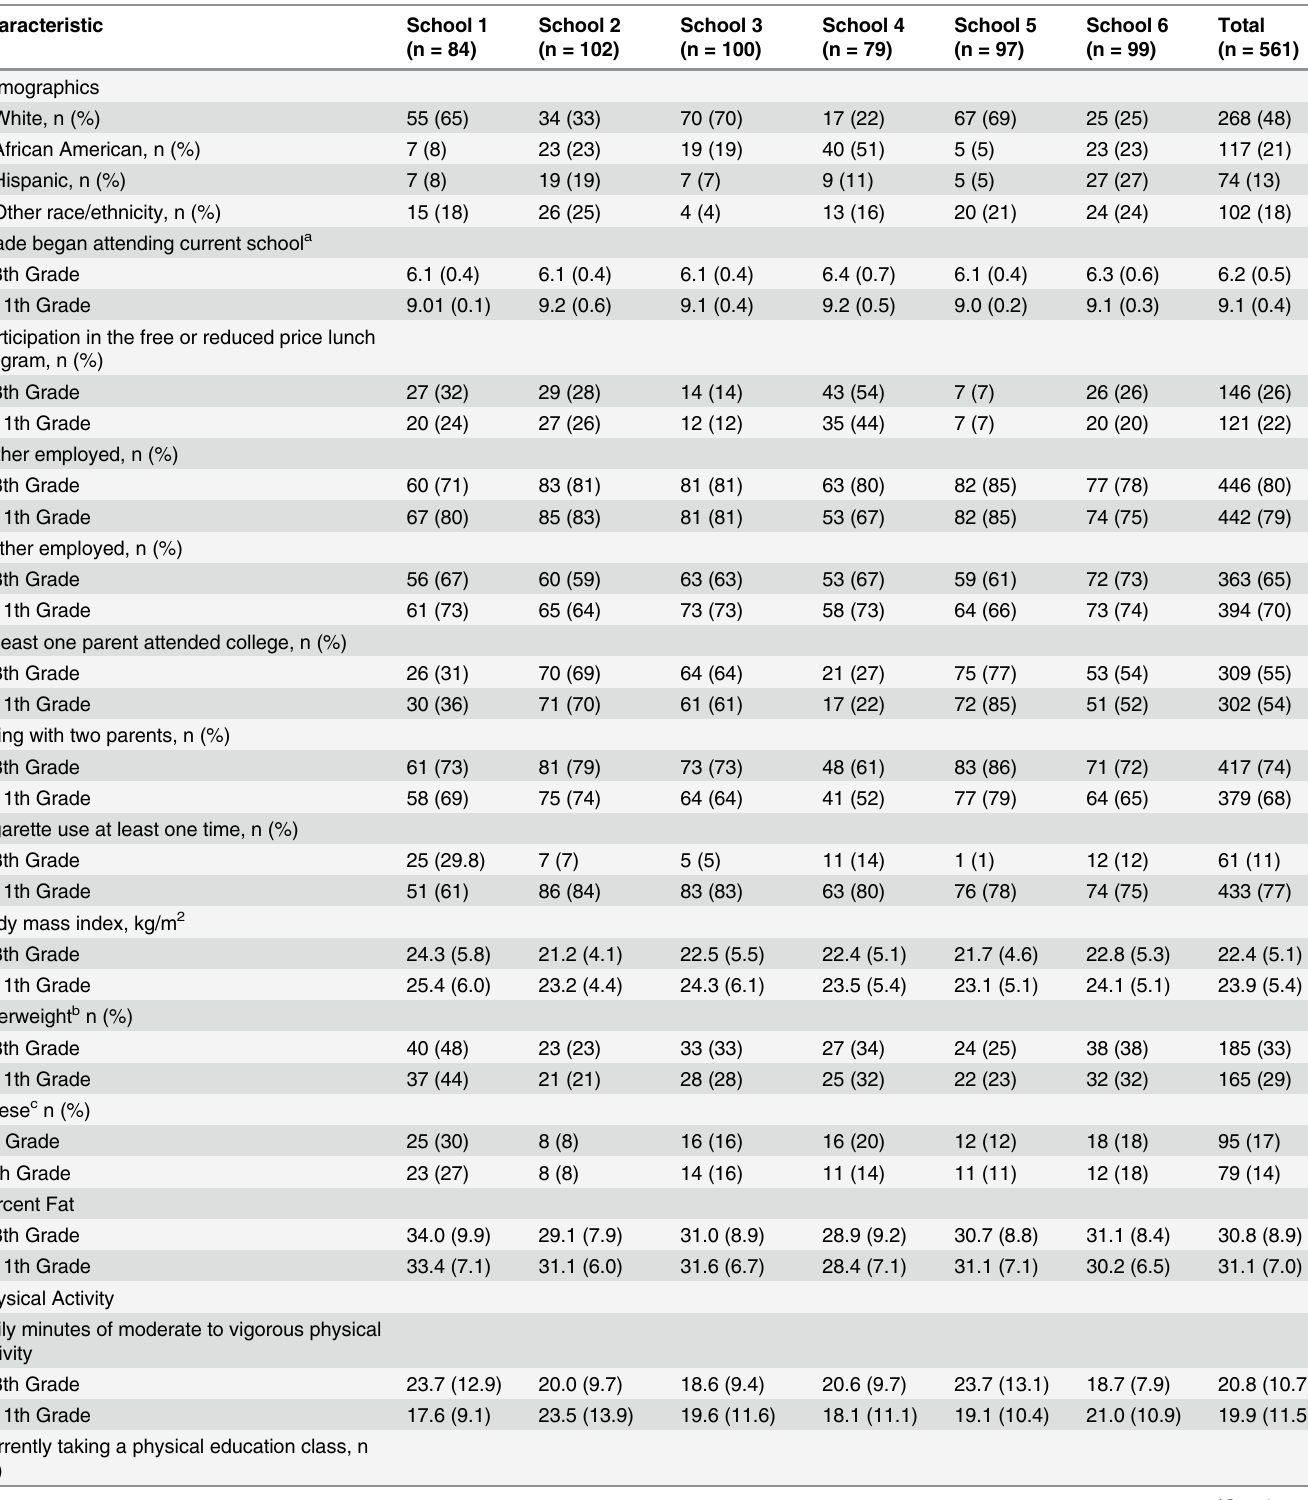
Table 2. Descriptive Characteristics for the Trial of Activity for Adolescent Girls (TAAG) (2006 8 th Grade) and TAAG2 (2009 11 th Grade) Studies, Maryland Field Site Cohort.